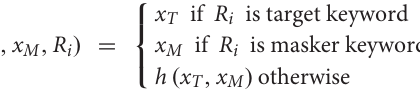
Frontiers in Neuroscience |